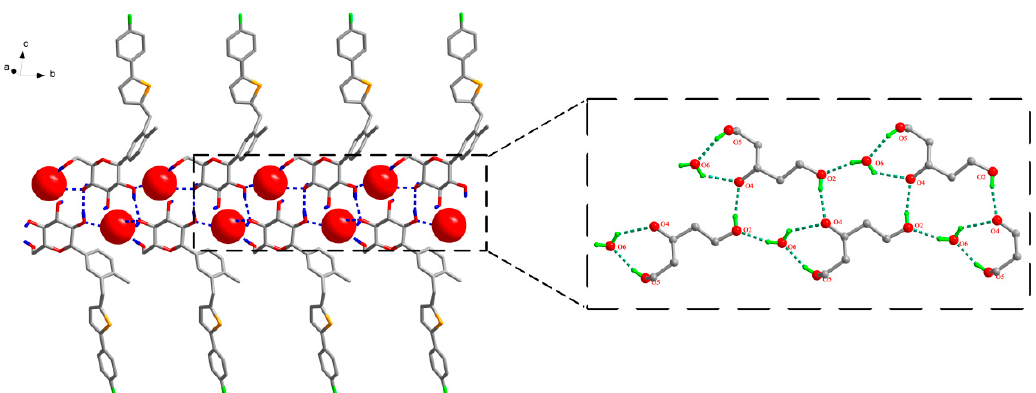
Figure 3. Water molecule and CG molecule interlinked by hydrogen bonds in the CG-H 2 O crystal structure. There were two types of ring motifs, i.e., R 4 (15), R 4 (7) along b axis. Hydrogen bonds were represented by dashed lines. For clarity, hydrogen atoms not involving in hydrogen bonds were omitted. Table 2. Intermolecular hydrogen bond geometry for CG-H 2 O.